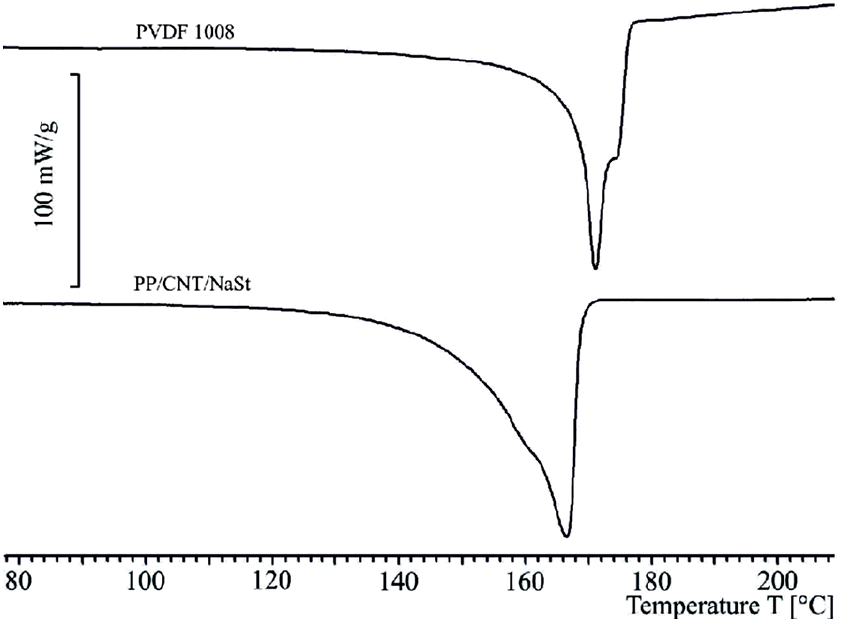
Figure 5. Differential scanning calorimetry (DSC) results, independently measured for the sheath material and core